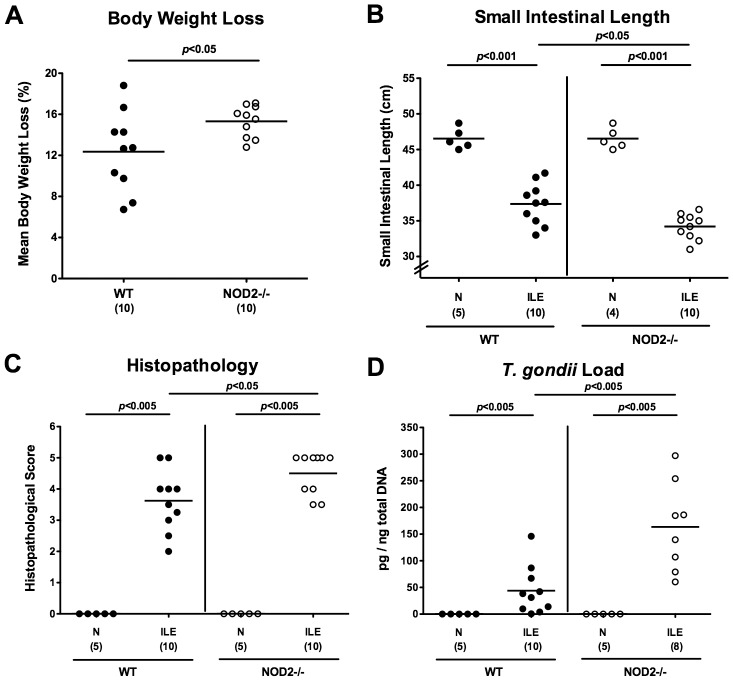
Acute ileitis in T. gondii infected NOD2 deficient mice.In order to induce acute ileitis, C57BL/6 wildtype (WT; black circles) and NOD2 deficient (NOD2-/-; white circles) were perorally infected with T. gondii at day 0. (A) Relative body weight loss between day 7 post infection (p.i.) and day 0 were determined (in %). (B) Absolute small intestinal lengths were measured in naïve (N) and T. gondii infected mice with ileitis (ILE). (C) Histopathological mucosal changes were assessed in ileal paraffin sections, and (D) T. gondii DNA determined in ex vivo ileal biopsies. Numbers of analyzed mice are given in parentheses. Means (black bars) and significance levels (p-values) determined by Mann-Whitney-U test are indicated. Data shown are representative for three independent experiments.